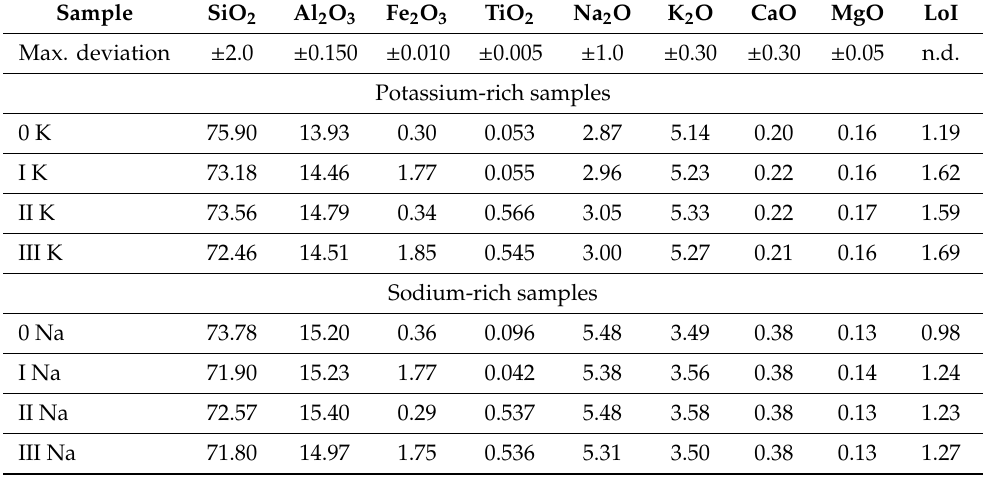
Figure 1. Color after firing of the studied samples: potassium (K) and sodium (Na) types doped with synthetic pigments (marked I-III) plus that of the basic samples (marked 0). Table 2. Analyzed weight % composition of the studied feldspar-quartz raw